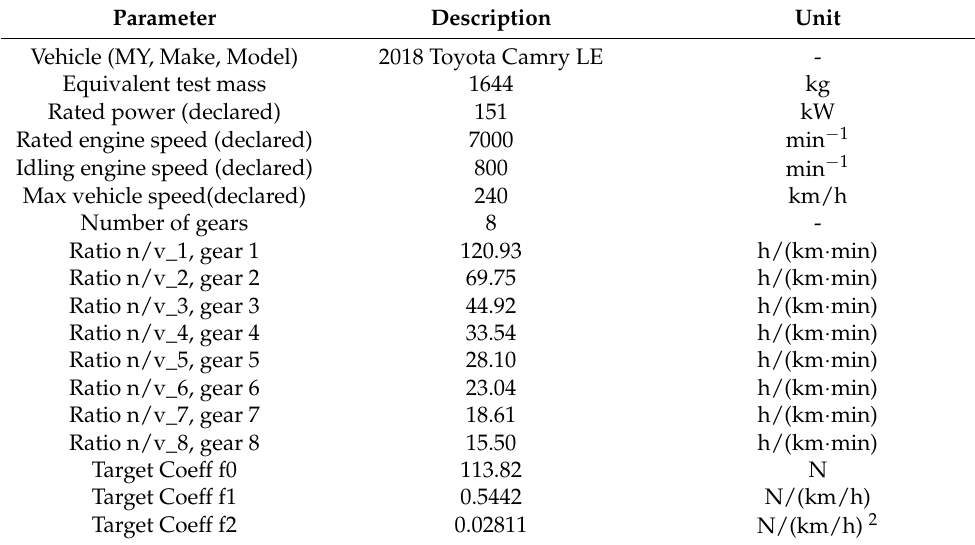
Table 2. Parameters of the vehicle used in the research for driving tests